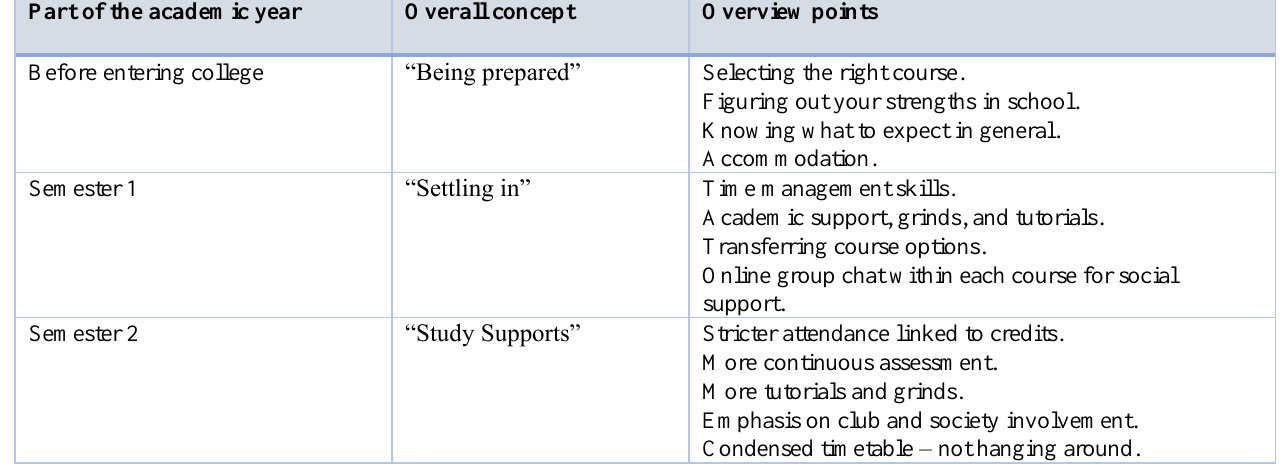
Overview of the Timeline of Supports